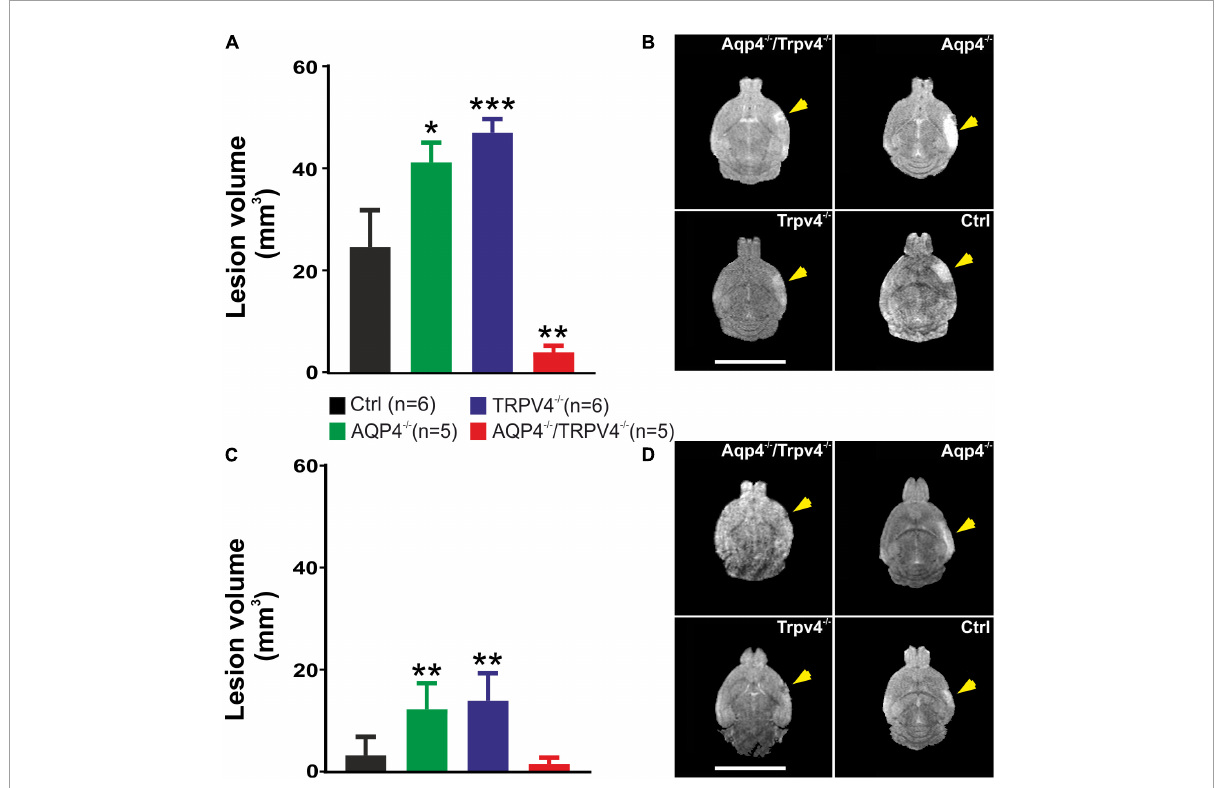
FIGURE1 Quantification of the ischemic lesion volume using T 2 -weighted magnetic resonance imaging of the mouse brain 1 day (D1) and 7 days (D7) after pMCAO. (A) Bar graph showing an average volume of the ischemic lesion in the AQP4 − / − , TRPV4 − / − , and AQP4 − / − /TRPV4 − / − mice compared to the Ctrl at D1 after pMCAO. Note that mice lacking AQP4 or TRPV4 channels showed significantly higher lesion volume, whereas the volume of the lesions in the mice lacking both channels was significantly reduced when compared to the single knockouts. (B) Representative T 2 -weighted images of the brains of the Ctrl, AQP4 − / − , TRPV4 − / − , and AQP4 − / − /TRPV4 − / − mice at D1 after pMCAO. The lesion is visible as a mild hyperintense area in the left hemisphere (yellow arrowheads). (C) Bar graph showing an average volume of the ischemic lesion in the AQP4 − / − , TRPV4 − / − , and AQP4 − / − /TRPV4 − / − mice compared to the Ctrl at D7 after pMCAO. Note that at D7 after pMCAO the lesion volume remains larger in the AQP4 − / − as well as TRPV4 − / − mice compared to the Ctrl, but in the AQP4 − / − /TRPV4 − / − , the lesion size is comparable to Ctrl. (D) Representative T 2 -weighted images of the brains of the Ctrl, AQP4 − / − , TRPV4 − / − , and AQP4 − / − /TRPV4 − / − mice at D7 after pMCAO. The lesion is visible as a mild hyperintense area in the left hemisphere (yellow arrowheads). Data are presented as mean + SEM. Asterisks indicate significant differences between the AQP4 − / − /TRPV4 − / − mice and the Ctrl (* p < 0.05, ** p < 0.01, *** p < 0.001). Ctrl, control; AQP4 − / − , AQP4-deficient mice; TRPV4 − / − , TRPV4-deficient mice; AQP4 − / − /TRPV4 − / − , AQP4- and TRPV4-deficient mice; pMCAO, permanent middle cerebral artery